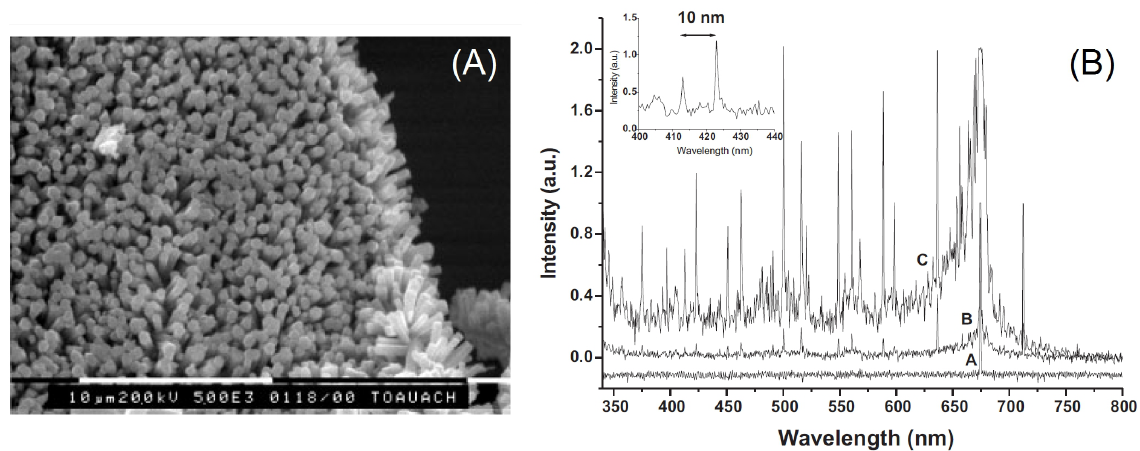
Figure 12: (A) Crystallographic representation of ZnO nanocolumns. (B) PL spectrum for the nanocolumns for a pump intensity of (A) below threshold, (B) 5.5 × above threshold and (C) 11 × above threshold. Inset shows expanded view of spectrum (C) showing a mode spacing of 10 nm. Reproduced with permission from Ref. [132]. PL: